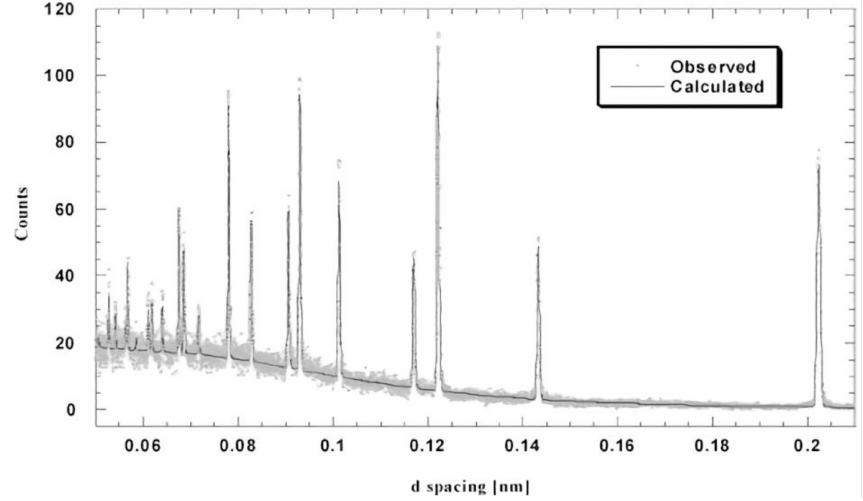
Figure 8. Time-of-flight pattern. Reproduced from [102] with permission from